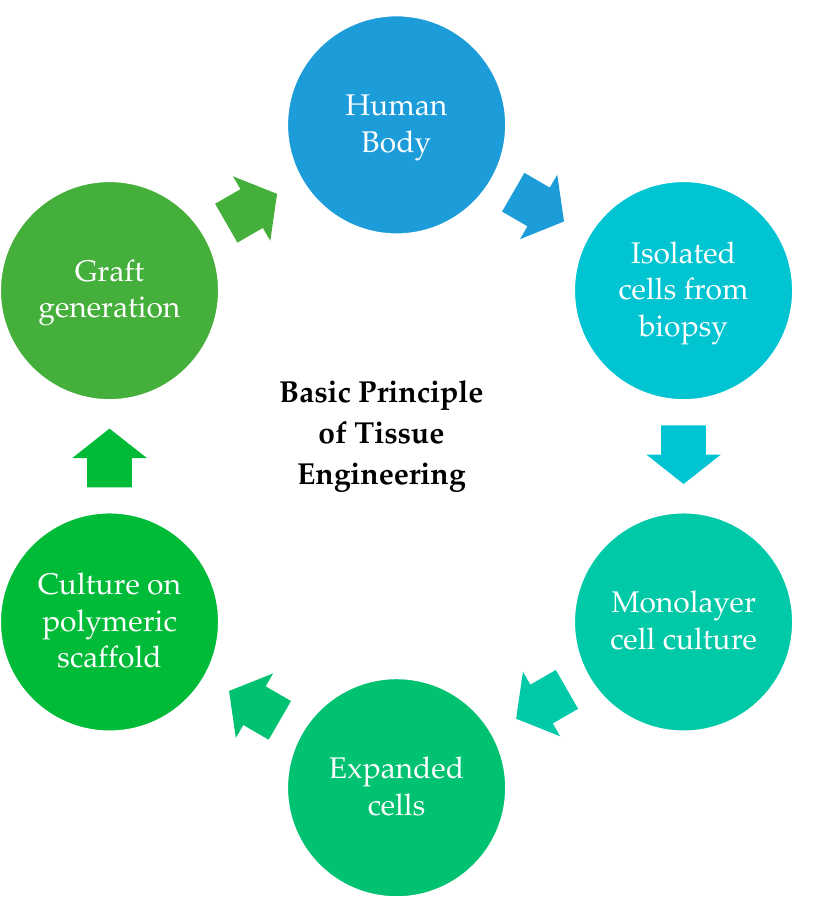
Figure 2. An illustration of the basic principle of TE, which includes cell isolation, cell culture, cell expansion, and tissue grafting into the patient’s body.